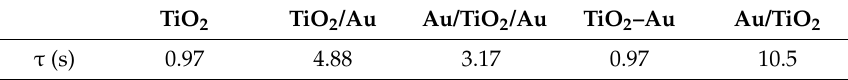
Table 5. τ values for the different samples evaluated at lnD = − 1.